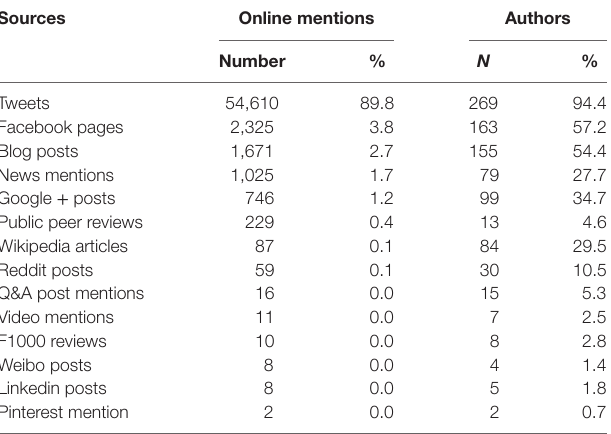
TaBle 8 | Distribution of Online mentions according to the source.